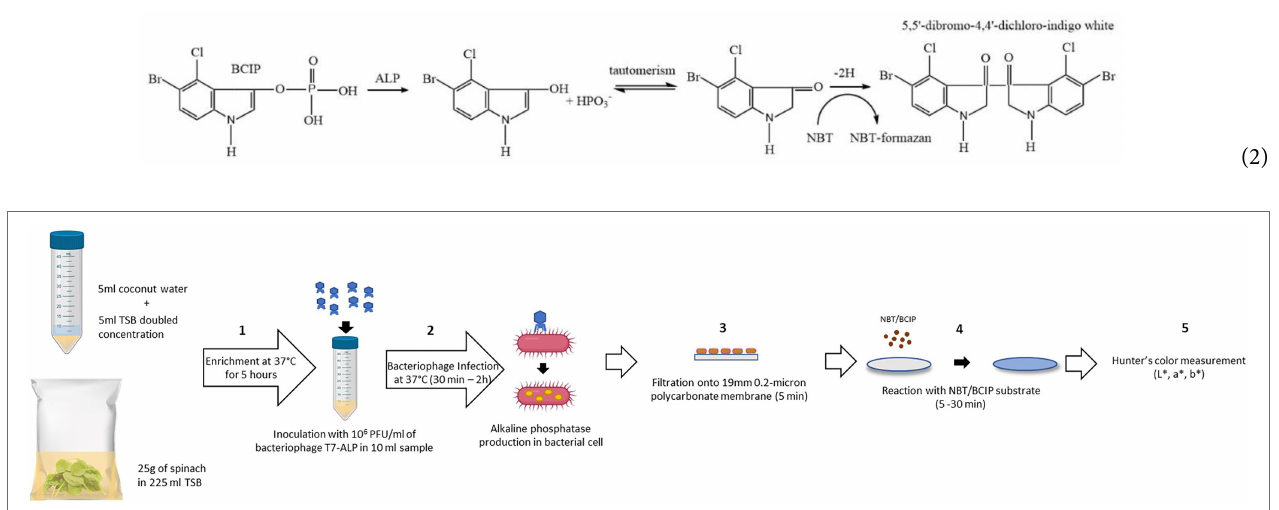
FIGURE 1 | Schematic diagram of the detection protocol based on alkaline phosphatase activity assay using colorimetric alkaline phosphatase substrates: NBT/ BCIP. (1) Enrichment of bacteria in spinach leaves without separation step (5 h). (2) Adding bacteriophage T7-ALP 10 6 PFU/ml for the infection of E. coli and alkaline phosphatase expression (30 min – 2 h). (3) Filtration to harvest the infected E. coli cells (5 min). (4) Adding NBT/BCIP substrate for enzymatic reaction and forming of precipitated products (5–30 min). (5) Color measurement using